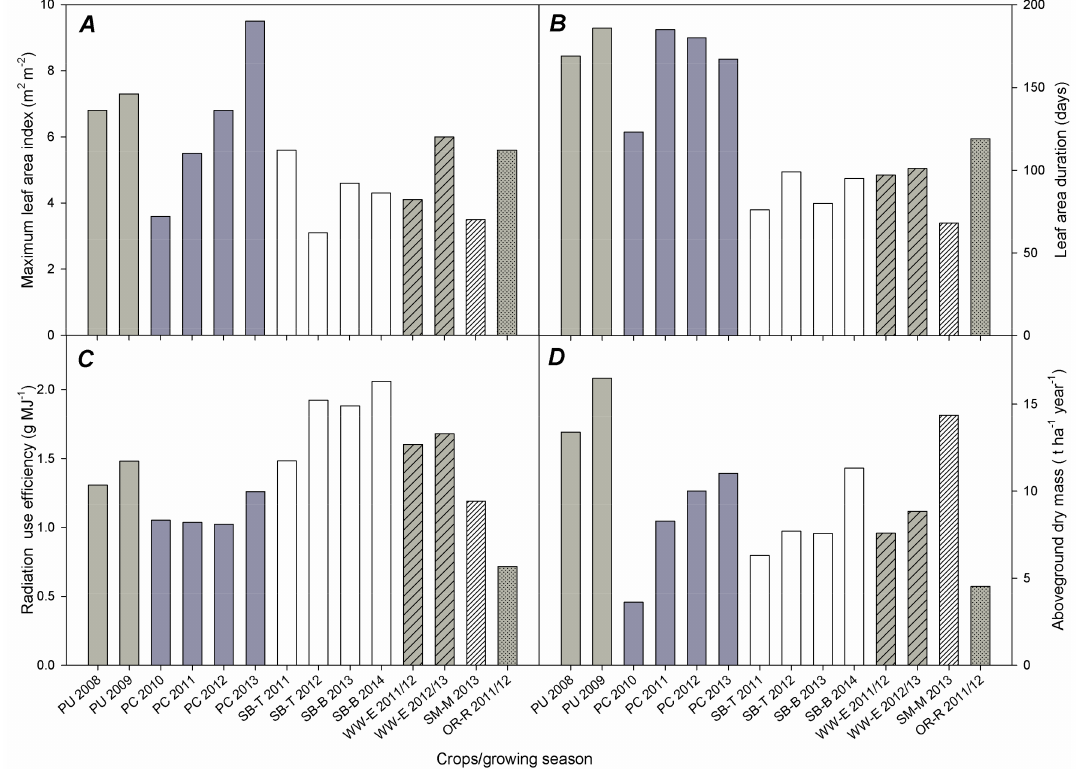
Figure 3. Comparison of ( A ) the maximum leaf area index (LAI max , m 2 m − 2 ); ( B ) the leaf area duration (LAD, days); ( C ) the radiation use efficiency (RUE, g MJ − 1 ); and ( D ) the aboveground dry